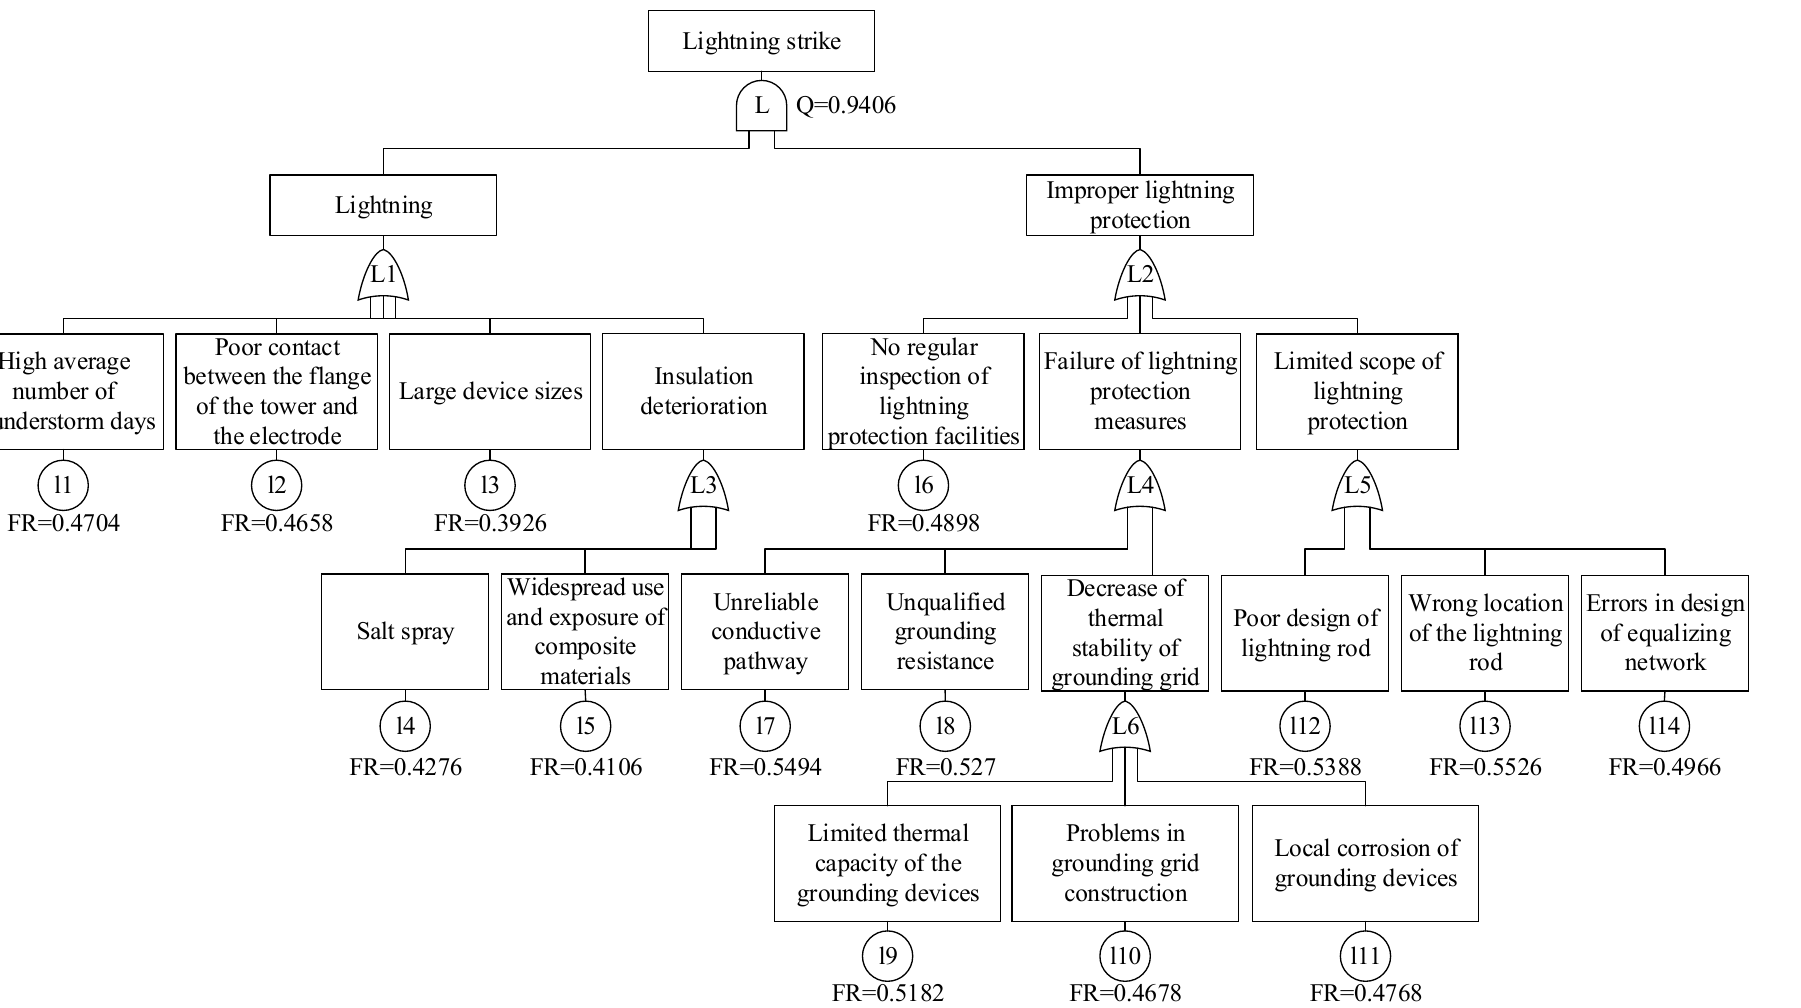
Figure 7. Fault tree analysis model for lightning strike risk of the offshore wind farm.